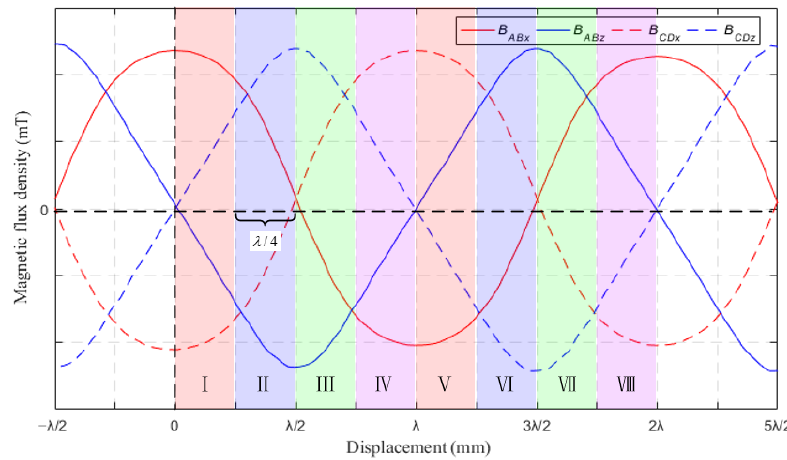
Figure 4. Schematic diagram of sensor displacement subdivision.